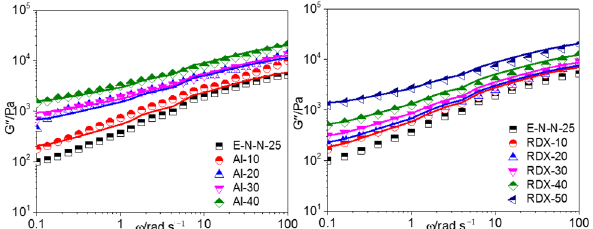
Figure 13. Measured values in dot and two-phase model simulation values in solid line under the curve G ″ - ω of model propellant at 130 °C.